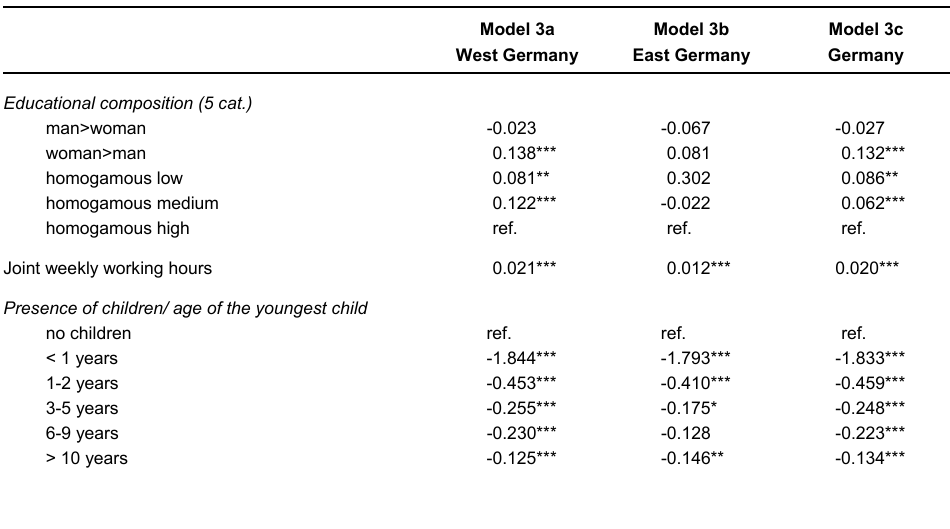
Table A5 : General Linear Models for women’s share of weekly working hours (by region) – including interaction terms between educational composition (5 cat.) and presence/age of the youngest